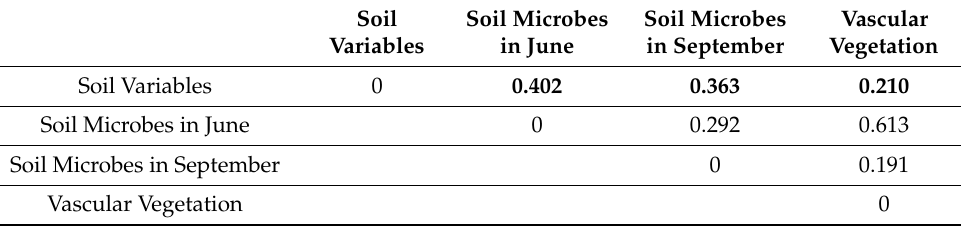
Table 3. Semi-matrix of dissimilarities between pairs of PCA ordination results of the four salt- affected habitat types at Apajpuszta, Hungary. Individual PCA ordinations were based on soil variables, on microbial activities in June and September and on vegetation survey data, then were compared by Procrustes analysis. Soil Soil Microbes Soil Microbes Vascular Variables in June in September Vegetation Soil Variables 0 0.402 0.363 0.210 Soil Microbes in June 0 0.292 0.613 Soil Microbes in September 0 0.191 Vascular Vegetation